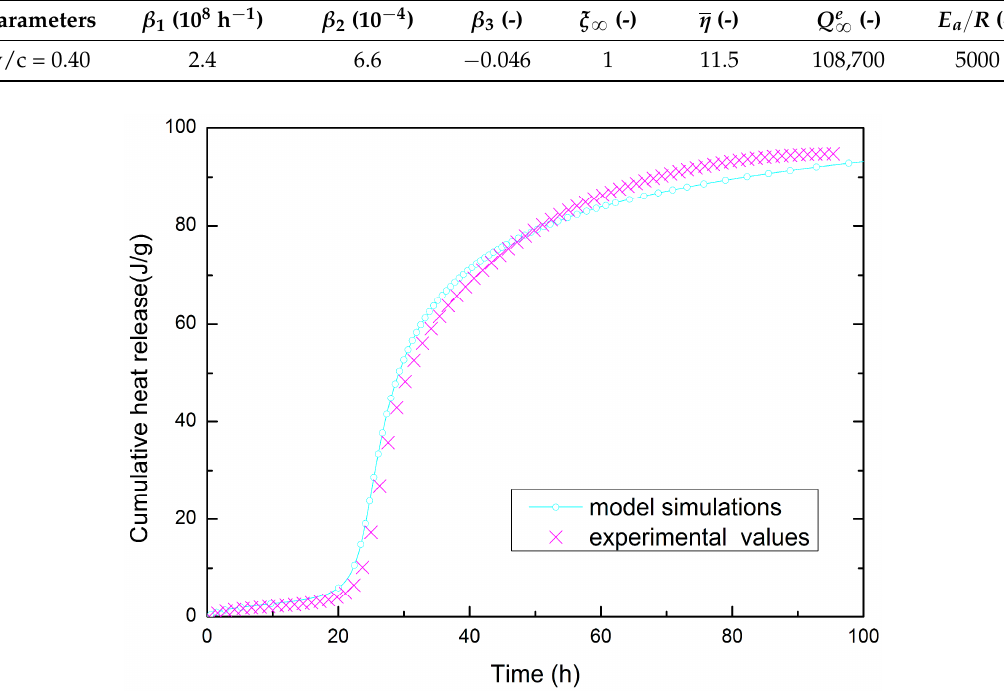
Figure 7. Hydration heat quantity curves for adiabatic test of SSC (w/c = 0.40).